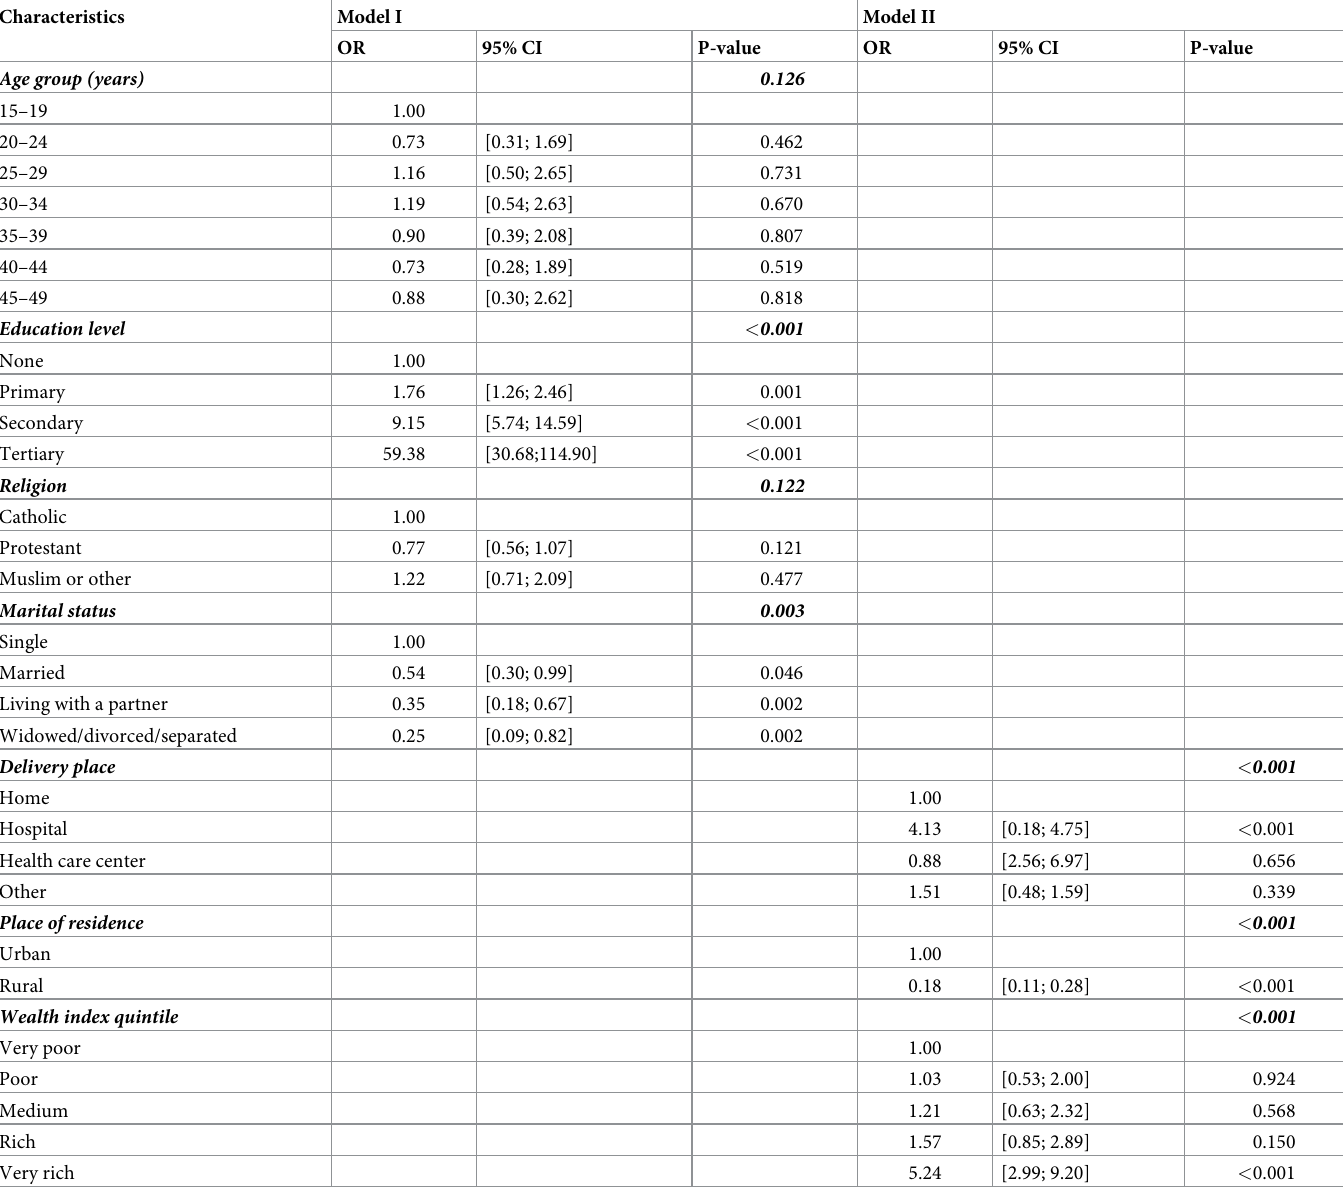
Table 4. Multi-level logistic regression models for individual and household-level factors associated with ANC with medical doctor in Burundi.